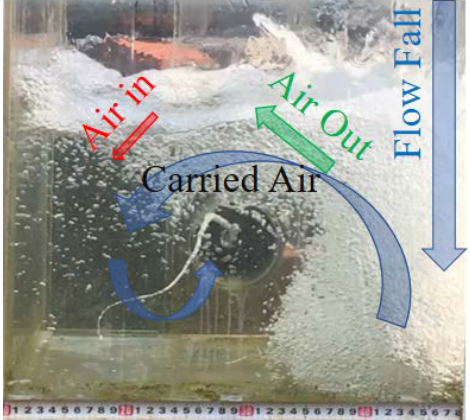
Figure 5. Front view of a forming process of the submerged horizontal vortex.